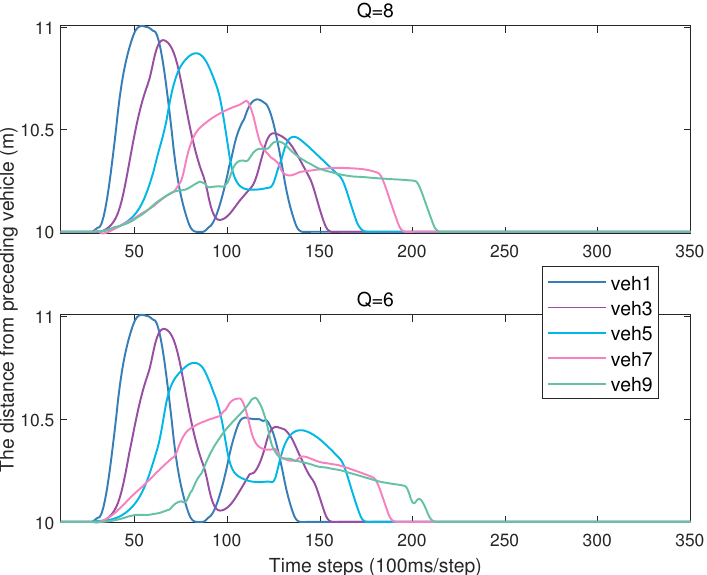
Figure 5. The distance between the corresponding PM and its predecessor.